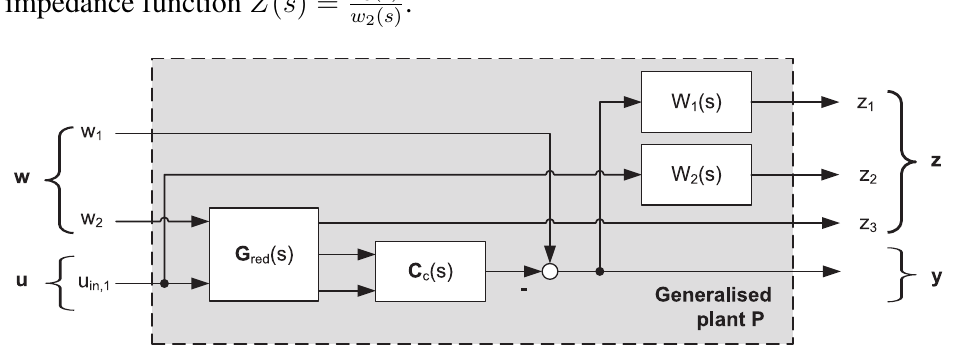
Figure 5. Generalized plant for augmented torque control with additional constraint in terms of the impedance function Z ( s ) = z 3 ( s ) w 2 ( s )